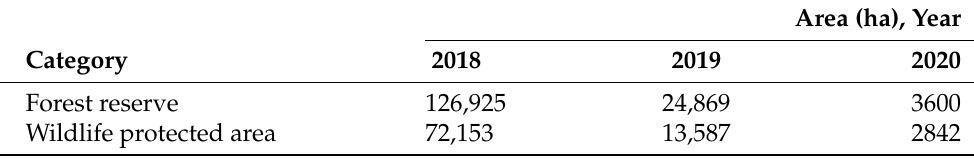
Table 15. Estimated forest cover change in protected